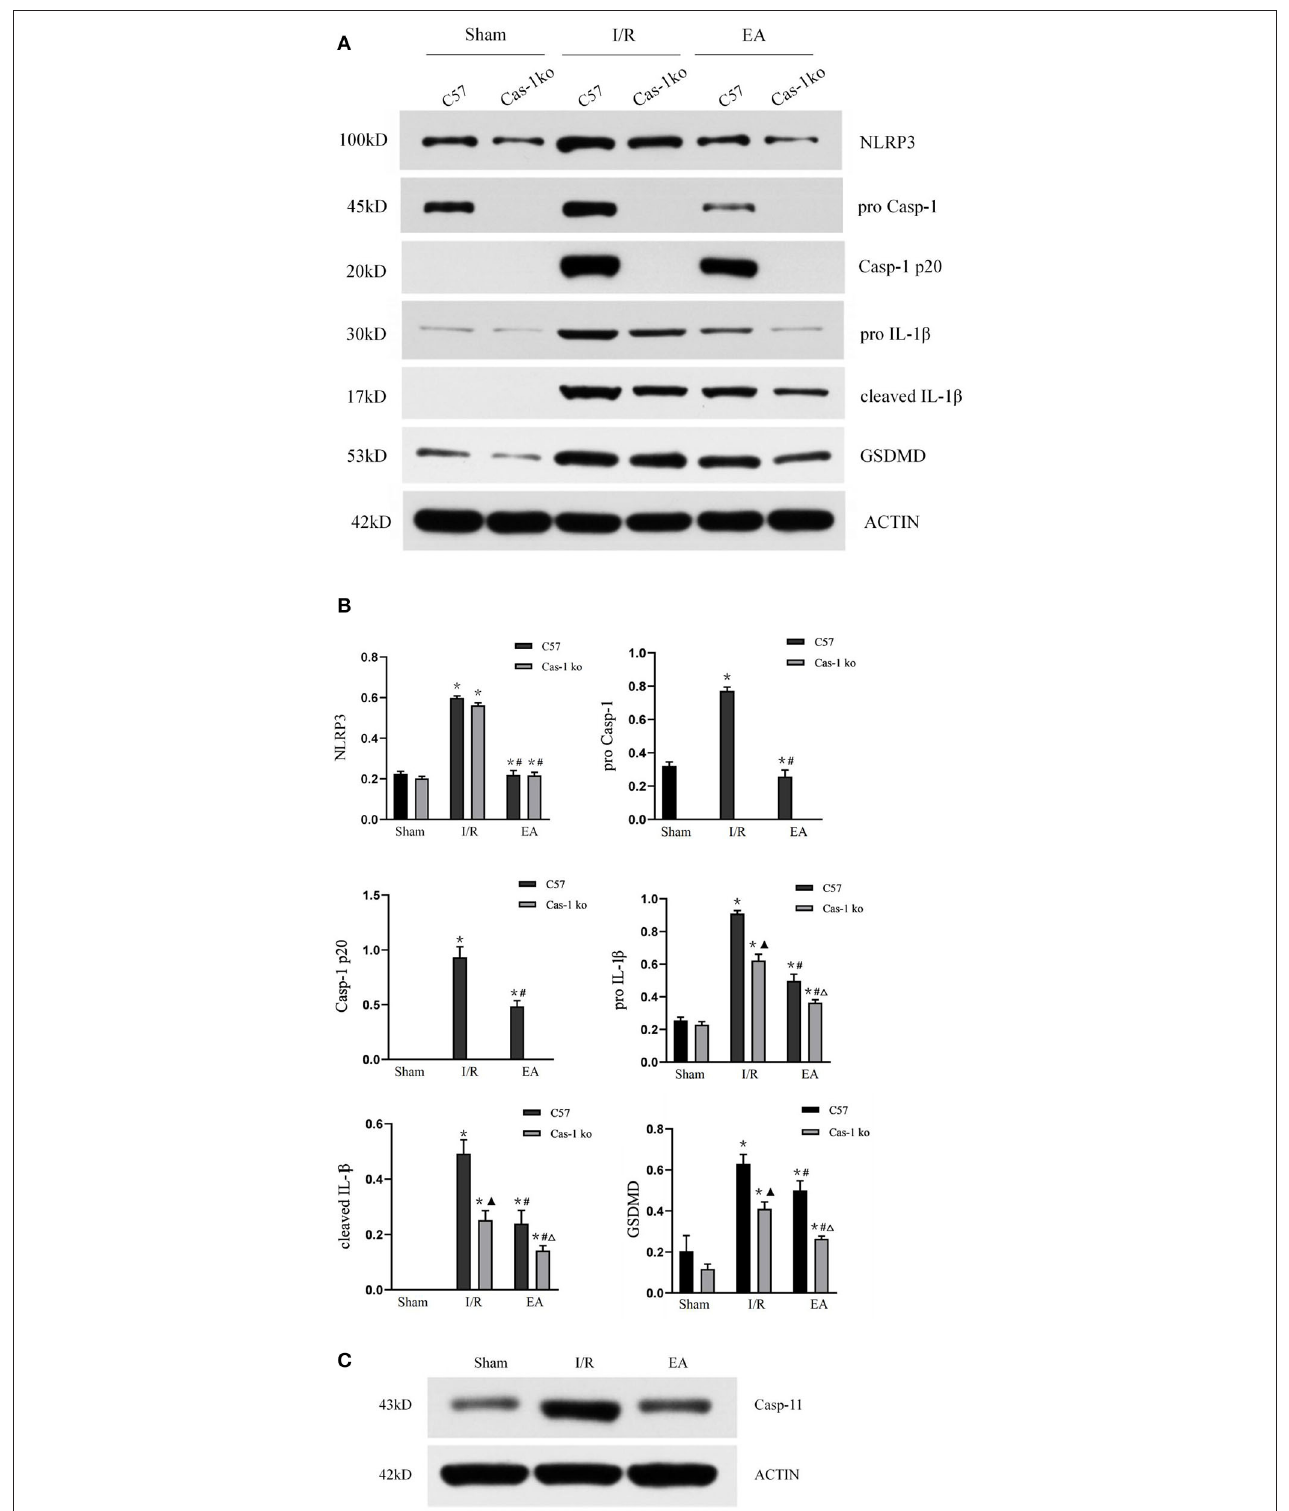
FIGURE 4 | Protein expression of pyroptosis-related proteins. (A,B) Western blotting analysis of NLRP3, pro-Casp-1, Casp-1 p20, IL-1 β , cleaved IL-1 β , and GSDMD in different treatment groups and quantitative analysis of bands. (C) Western blotting analysis of casp-11 in Cas-1 ko mice. Comparison within the same genotype: * p < 0.05 vs. Sham group; # p < 0.05 vs. I/R group. Comparison within the I/R group: N p < 0.05 vs. C57 mice. Comparison within the EA group: 1 p < 0.05 vs. C57 mice. Data are representative of two (C) or four independent experiments [ (A,B) mean ± SD are representative of values from four independent experiments in (B) ].